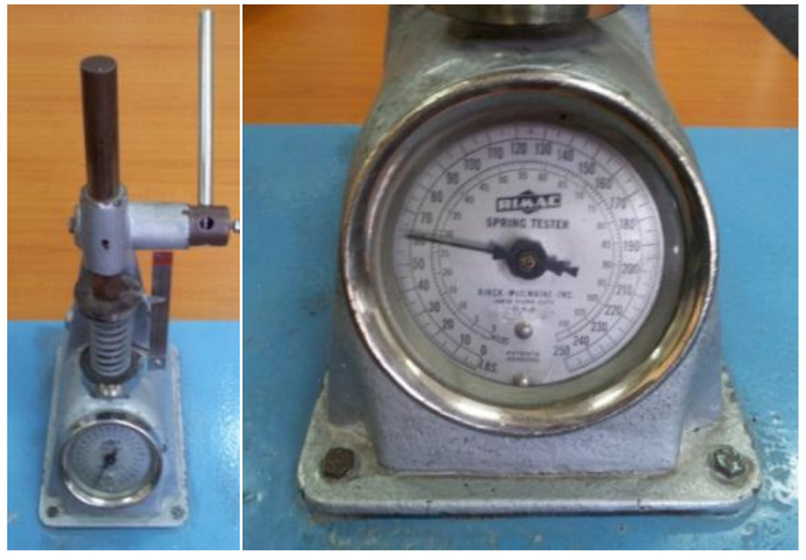
Figure 7. Test stand. Thus, the springs corresponding to one cylinder were removed, two from the inlet valves and two from the exhaust valves, and their elastic characteristics were determined, entering in the table the values corresponding to the applied weights and their deformation (see Table